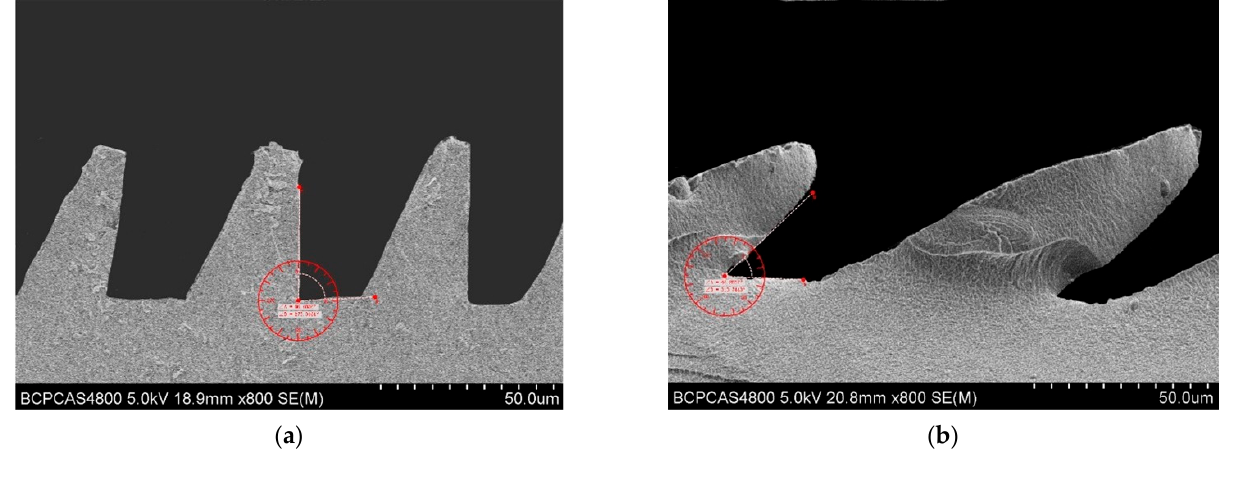
Figure 14. Bionic microstructures at different tilt angles. ( a ) Vertical microstructure; ( b ) 45° tilted microstructure.